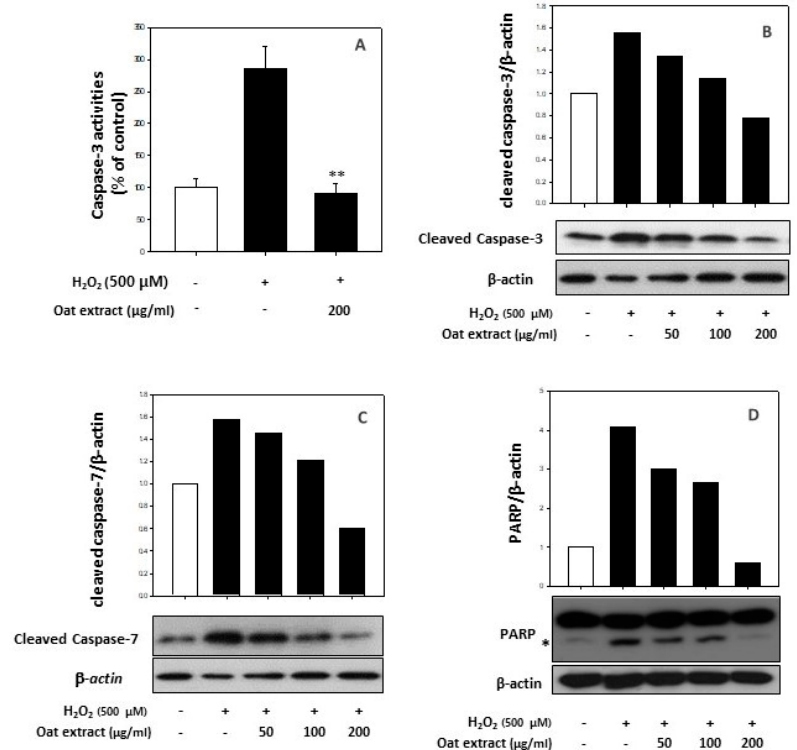
Figure 6. Effect of oat ( Avena sativa, cv. Daeyang) 80% ethanol extract on caspase-3 enzyme activity ( A ), cleaved caspase-3 protein ( B ), cleaved caspase-7 protein ( C ) and cleaved PARP protein levels ( D ) in human keratinocytes HaCaT. The asterisk adjacent to the lower band of PARP indicates the cleaved PARP protein. Cells were treated with various concentrations (50–200 µ g/mL) of oat 80% ethanol extracts for 24 h, followed by treatment with 500 µ M H 2 O 2 for 24 h. Caspase-3 enzymatic activity was determined using colorimetric assay. ** p < 0.01 vs. without oat extract. Cleaved caspase-3, cleaved caspase-7 and cleaved PARP protein levels were assessed using immunoblotting in the same sample set. β -Actin was used as a loading control.